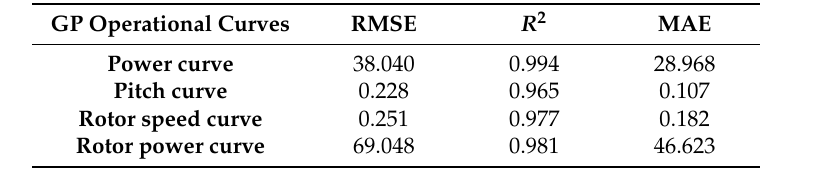
Table 3. Statistical measures for GP operational curve models.